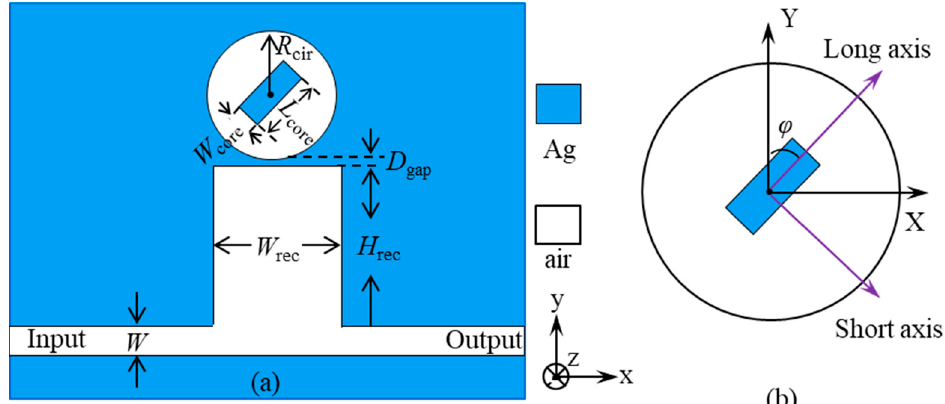
Figure 1. ( a ) Schematic illustration of a two-dimensional plasmonic metal-insulator-metal (MIM) nanosystem consisting of a rectangular cavity coupled with a waveguide, and an upper-coupled circular cavity with an angle-tunable metal strip located at the center. ( b ) In the metal-strip-core circular cavity, the rotation direction of the metal strip is defined by an angle ϕ between the y -axis and the long axis of the metal strip.